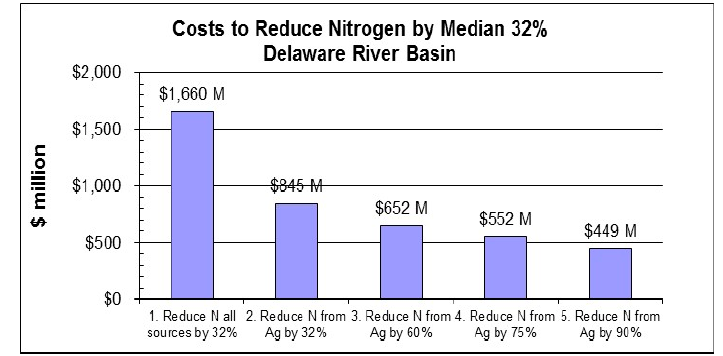
Figure 10. Costs (in 2010 dollars) to reduce nitrogen loads by 32% in the Delaware Basin.